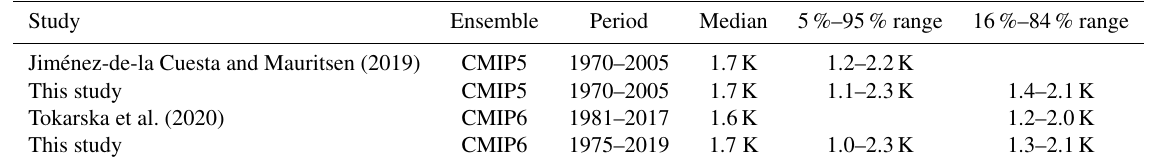
Table 3. Emergent constraint on TCR depending on choices of ensemble and period. Results from JM19 and Tokarska et al. (2020) are also shown for